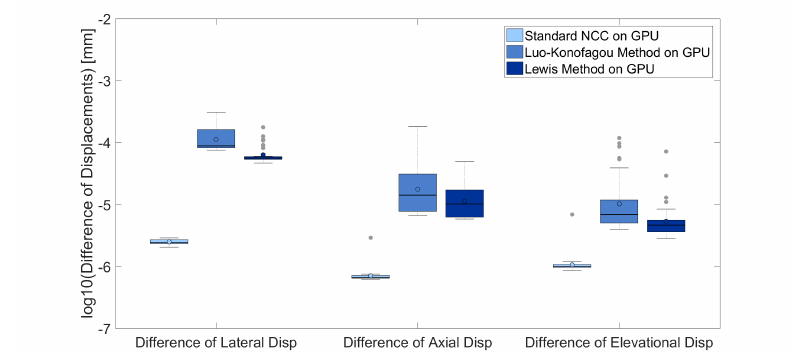
Figure 5. Clustered box plots illustrating absolute displacement difference values obtained from the standard-NCC-CPU implementation and three different GPU implementations (standard-NCC-GPU, Lou-Konofagou-GPU, Lewis-GPU). The top and bottom of the boxes indicate 75 and 25 percentiles, respectively. The line through the middle of each box represents the median. The error bars show the minimum and maximum values. The gray “dot-shaped” markers indicate